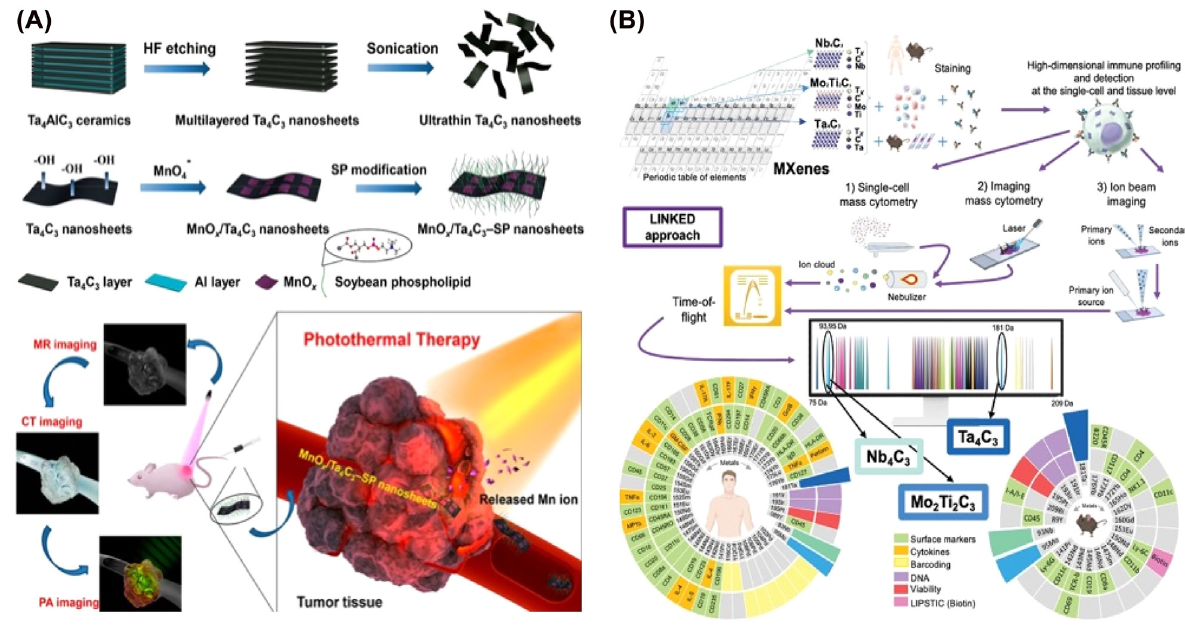
C were the high-performance contrast 4 3 C Mo Ti C and Ta C for detecting cells and tissues 4 3, 2 2 3, 4 3